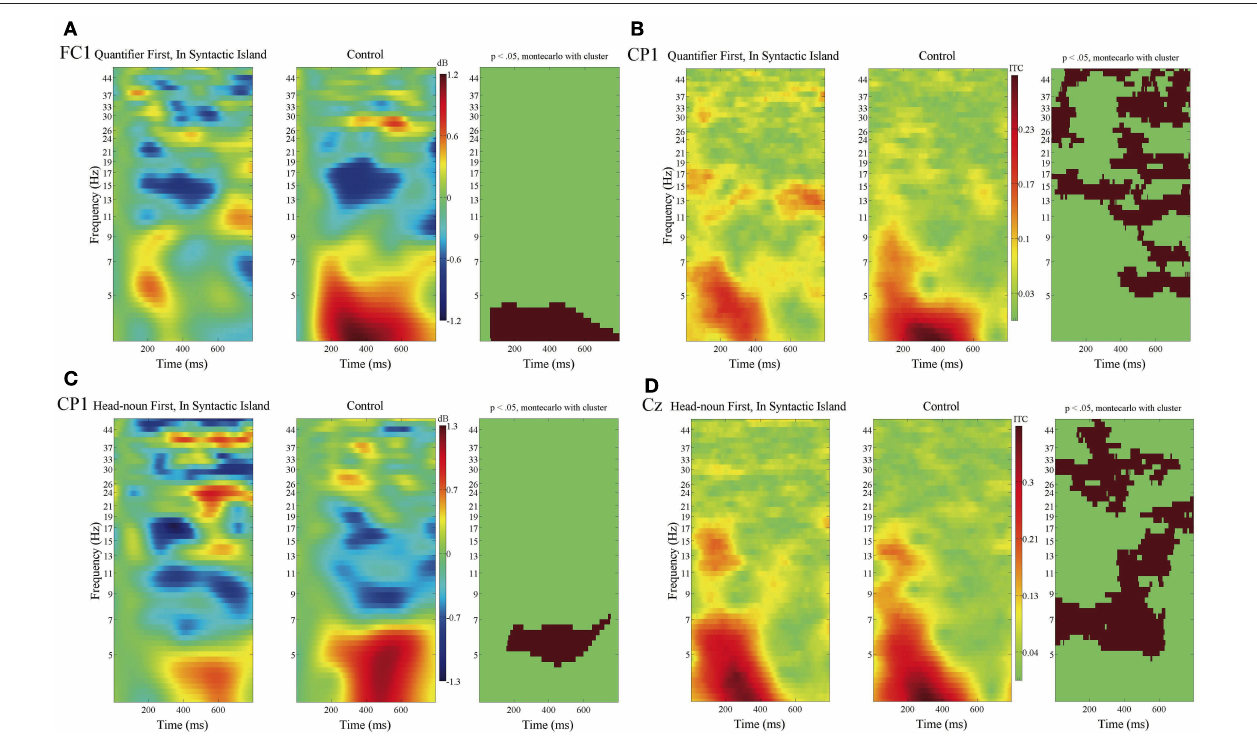
FIGURE 9 | ERSPs and the ITCs time-locked to the onsets of the subordinate verbs of Quantifier First, Head-noun First, and the control condition in (A–D) with the baseline from 0 to 100 ms. The ERSP at FC1 in (A) and the ITC at CP1 in (B) for Quantifier First and the control condition, and the ERSP at CP1 in (C) and the ITC at Cz in (D) for Head-noun First and the control condition. Time windows and frequency bands are depicted in red, where significant differences were determined between In Syntactic Island and the control condition by using the cluster-based permutation test ( p < 0.05).